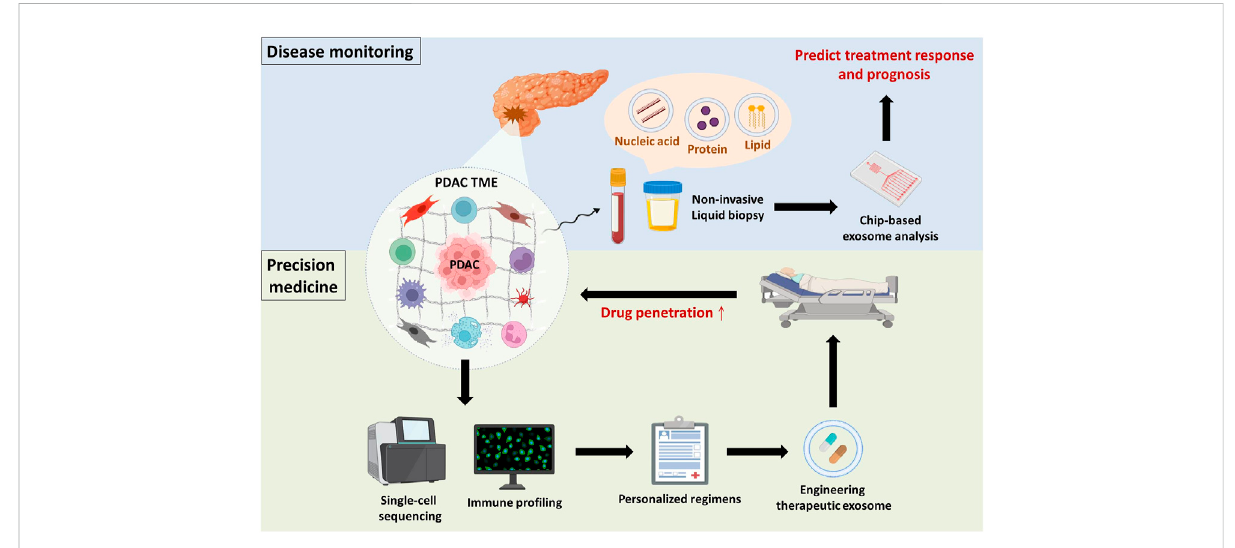
FIGURE 3 Overview and future perspectives. Disease monitoring: PDAC or tumour microenvironmental cell-derived exosomes are detected in body fl uids(e.g.,bloodandurine),andtheircargosareindicativeofPDACprogression.Takingadvantageofchip-basedexosomeanalysiscanimmediately predicttreatmentresponseandprognosis.Precisionmedicine:ComponentsoftheTME(e.g.,immunecells,stromalcellsandECM)makesubstantial contributions to PDAC progression. Hence, single-cell sequencing of tumour microenvironmental components in combination with immune pro fi ling provides physicians with comprehensive information to establish personalized regimens. Subsequently, drug candidates can be encapsulated in exosomes to improve drug